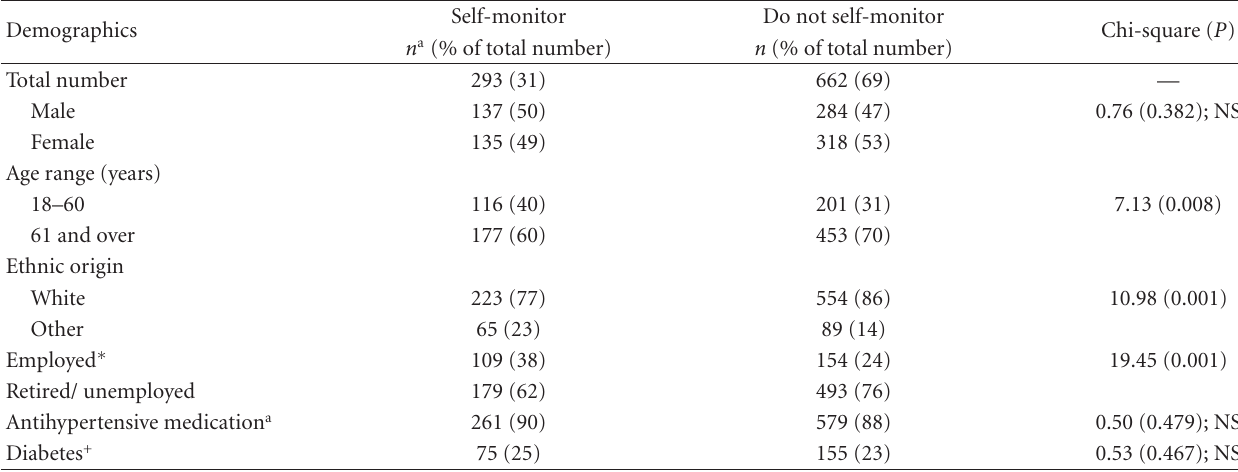
Table 1: Characteristics of people self-monitoring and not self-monitoring blood pressure.